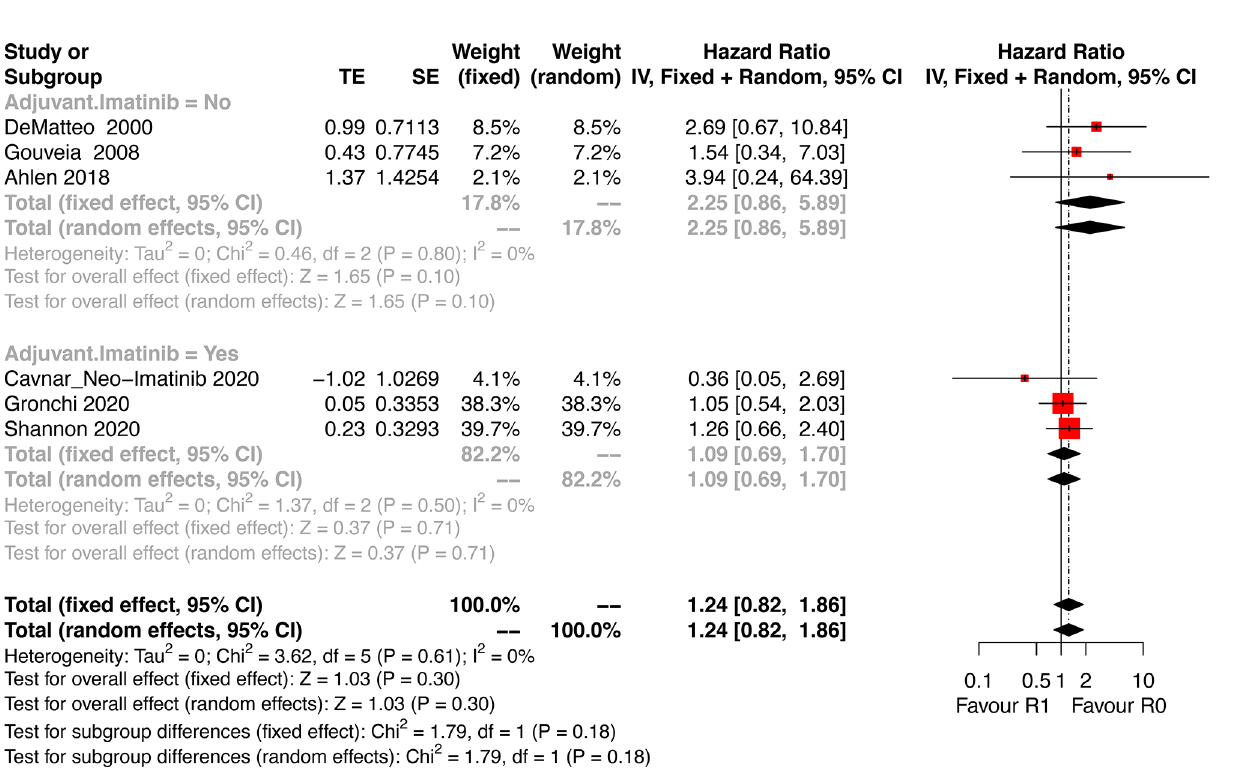
FIGURE 4 | Forest plots illustrating overall survival between R1 and R0